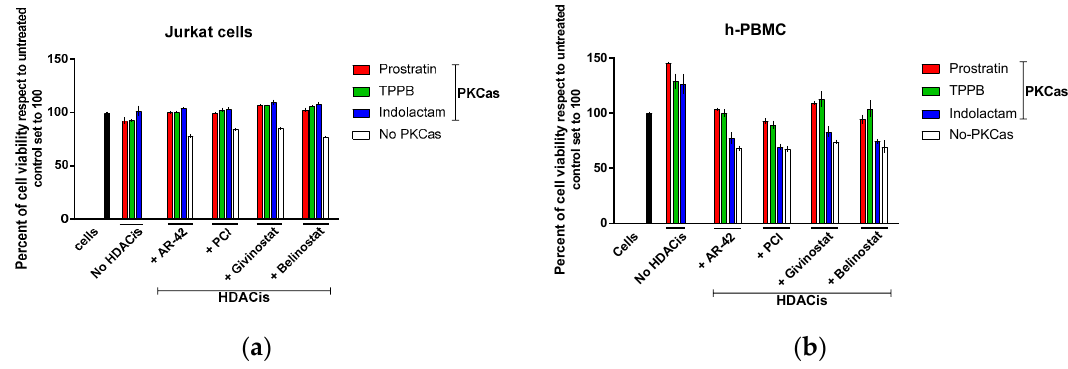
Figure 2. Cellular toxicity assessment of combinations of LRAs in uninfected cells. The effect of combinations of LRAs on cell viability in Jurkat cells ( a ) and human PBMCs ( b ) following 48 h treatment was measured with CellTiter-Blue ® Cell Viability assay. Black columns represent untreated cells; red columns are cells treated with prostratin in combination with or without HDACis; green columns are cells treated with TPPB in combination with or without HDACis; blue columns are cells treated with indolactam in combination with or without HDACis; and white columns are cells treated with a single HDACi. Data are shown as mean ± S.D. of three independent experiments.